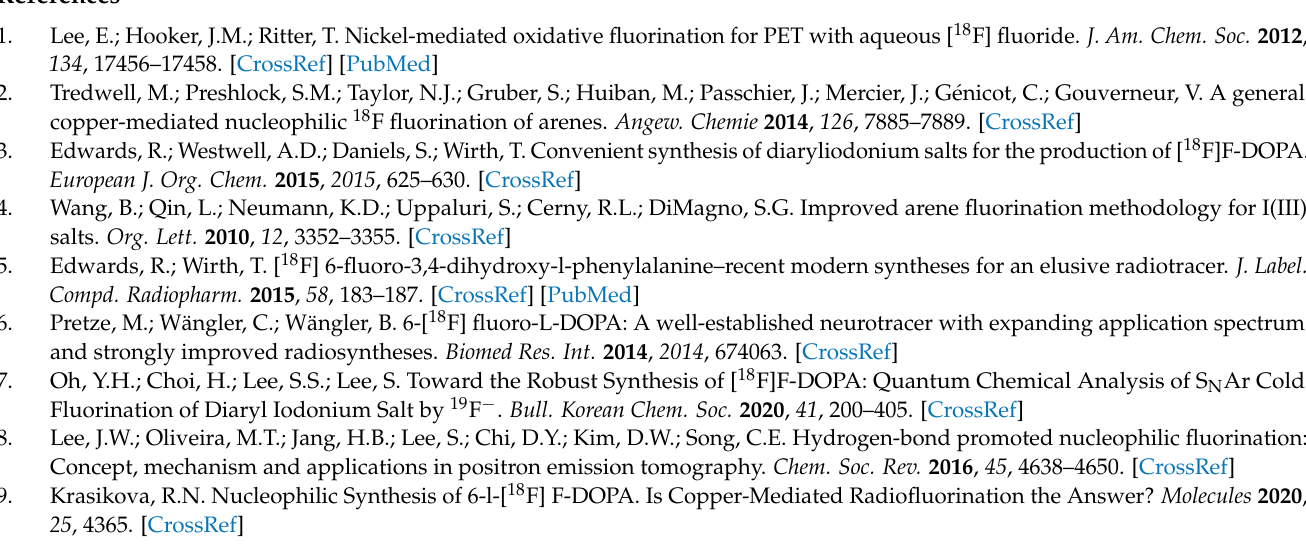
Supplementary Materials: Figure S1: Pre- and post-reaction complexes and the transition states of 18 F-fluorination using TBMA- 18 F in CH 3 CN; Figure S2: Pre- and post-reaction complexes and the transition states of E2 reactions using TBMA- 18 F in CH 3